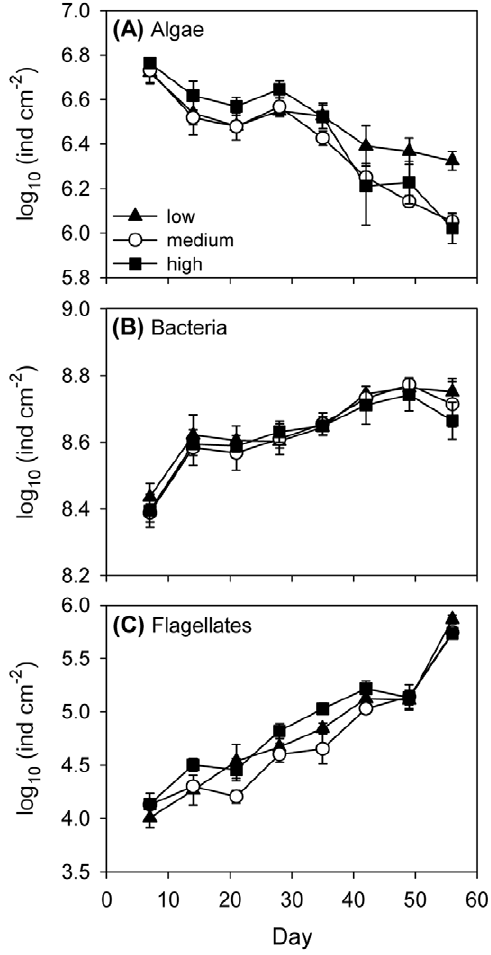
Figure 6. Resource abundances in the three connectivity treatments. (A) algae, (B) bacteria, and (C) flagellates, means 6 SE, n=3.